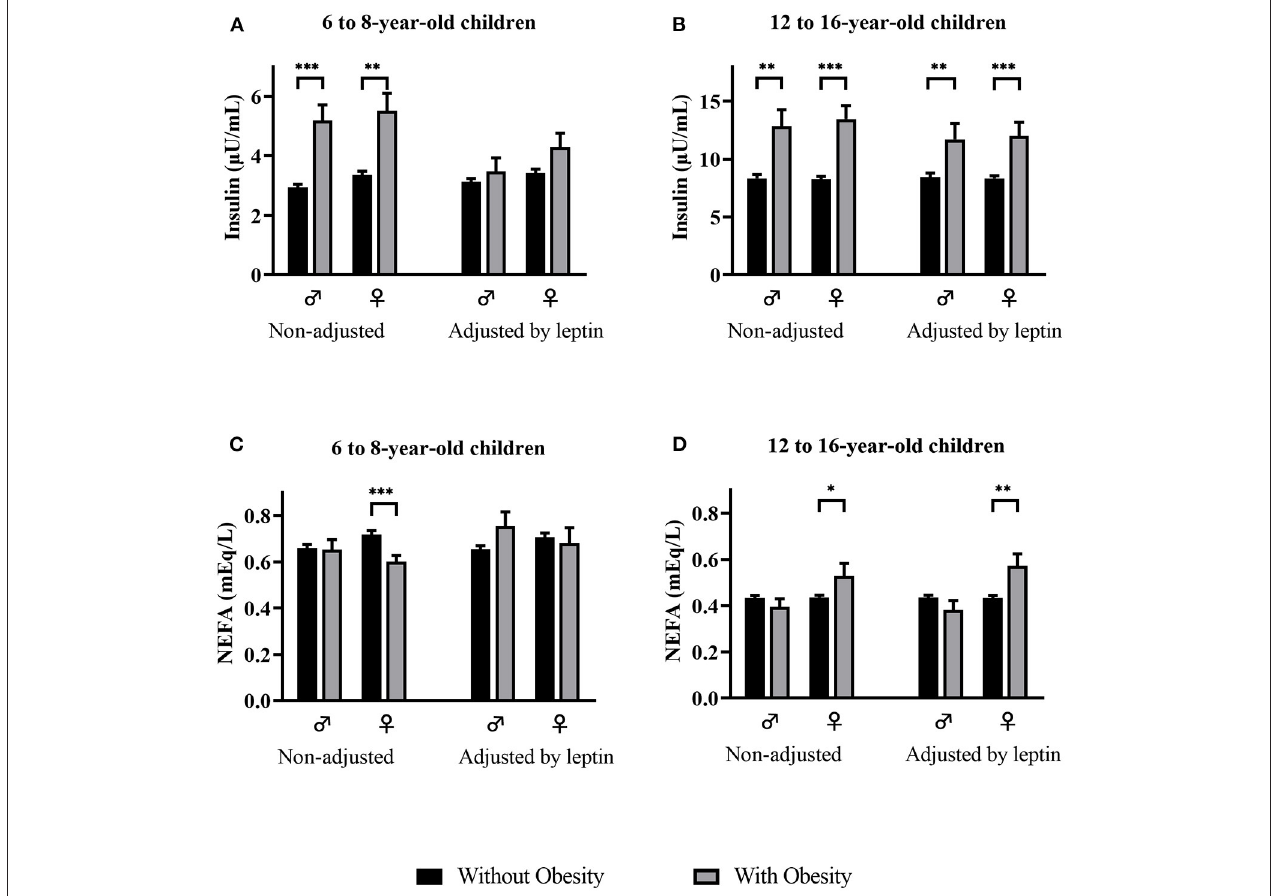
FIGURE 1 | Insulin (A,B) and NEFA (C,D) levels (mean and std. error) by weight category, non-adjusted and adjusted by leptin levels, in males and females of both age groups. NEFA, non-esterified fatty acids. p -value: ANCOVA * p < 0.05; ** p < 0.01; *** p <